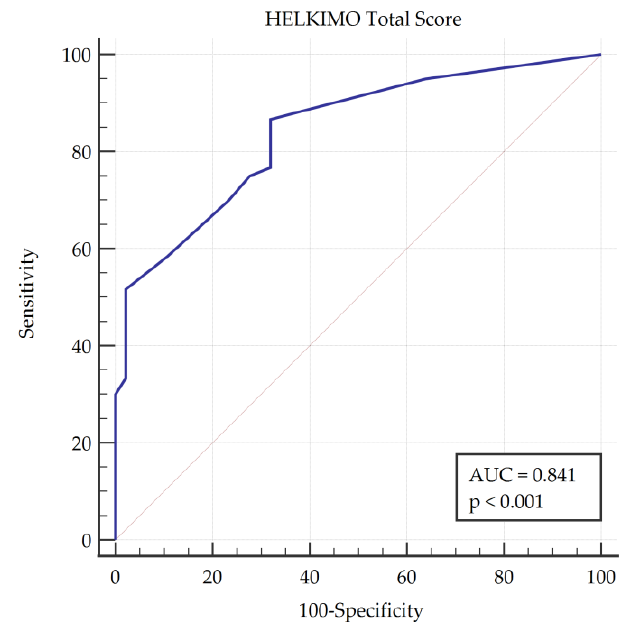
Figure 2. Receiver operating characteristic (ROC) curve plot showing the area under the curve (AUC). Table 4. Predictive values of the Helkimo Clinical Dysfunction Index (HCDI) total score by ROC curve analysis for the diagnosis of TMDs.